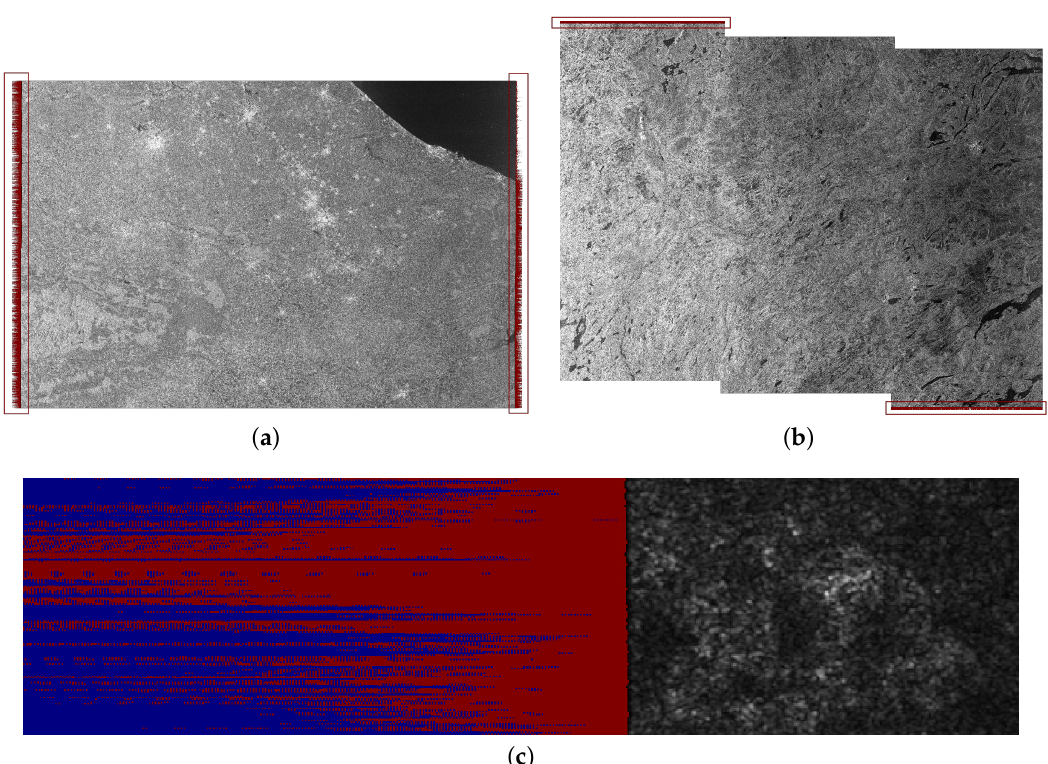
Figure 1. Spurious dark pixels generated at the borders of Sentinel-1 GRD images, highlighted in red: ( a ) cross-track border noise in the range direction (left and right); ( b ) along-track border noise in the azimuth direction (top and bottom); ( c ) close-up of the border noise, highlighted in red, mixed with samples correctly set to zero by the Instrument Processing Facility (IPF), highlighted in blue. Sentinel-1 images c (cid:13) Copernicus